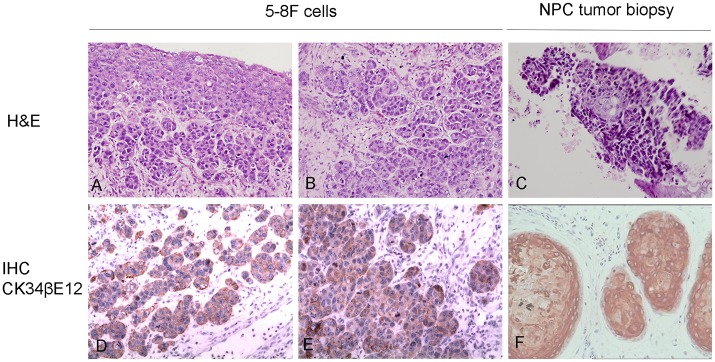
Histochemistry, and immunohistochemistry staining of xenografts.A-C: H&E staining of derived xenografts 120 h after inoculation with 1×106 5-8F cells or primary tumors. Representative images are shown. D-F: IHC staining of human CK34βE12. Magnification, ×400.